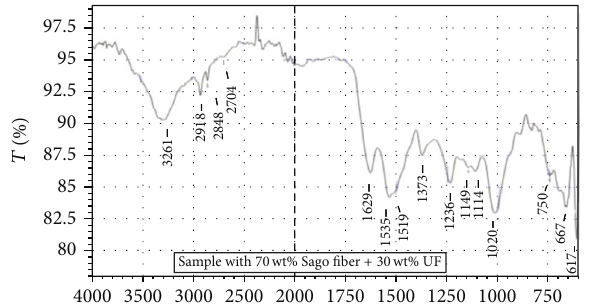
Figure 8: Sample F: Sago/UF Sample with 70: 30.